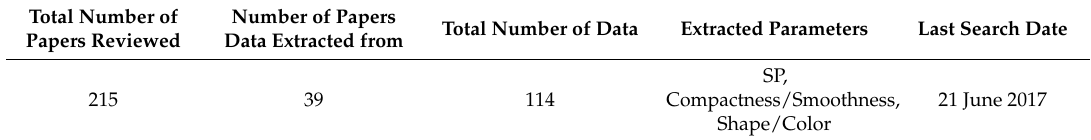
Table 2. General information on the review process and the data extracted from reviewed papers.